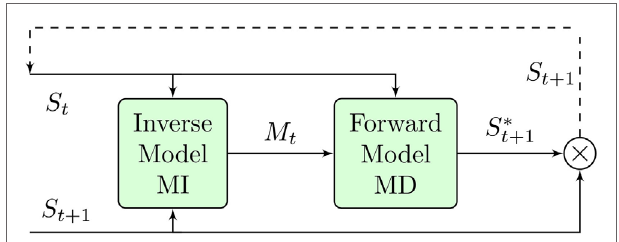
FigUre 3 | saccadic control integrated model (explanation in text)